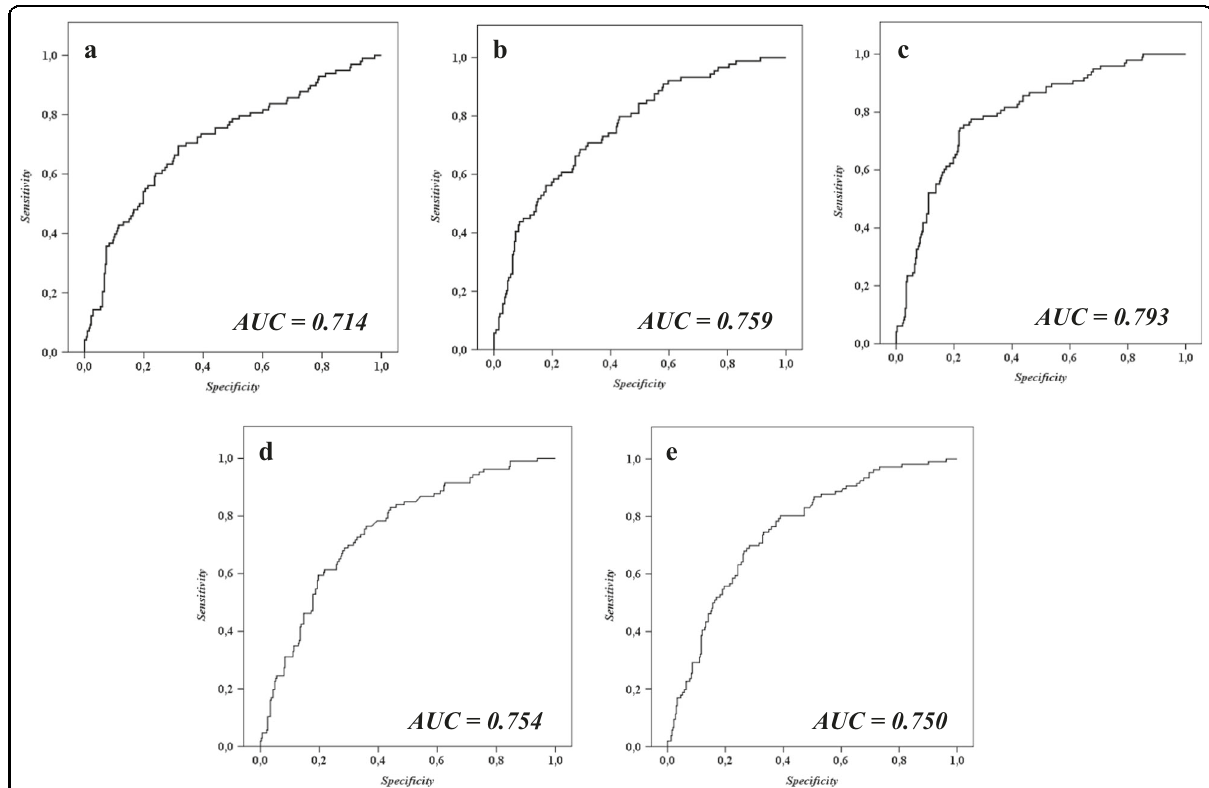
Fig. 4 Receiver operating curves (ROC) analysis. a ROC model including clinical variables (age, gender, BMI, HDL-C, TG, HbA1c, fasting glucose and fasting insulin); ( b ) ROC model including clinical variables and OGTT-derived indexes (DI, MISI, ISI, HIRI, and IGI); ( c ) ROC model including clinical variables and studied miRNAs; ( d ) ROC model including studied miRNAs and FINDRISC score; and ( e ) ROC model including studied miRNAs and ADA score. The analyses were performed using SPSS (now PASW Statistics for Windows (version 21.0) (IBM. Chicago,